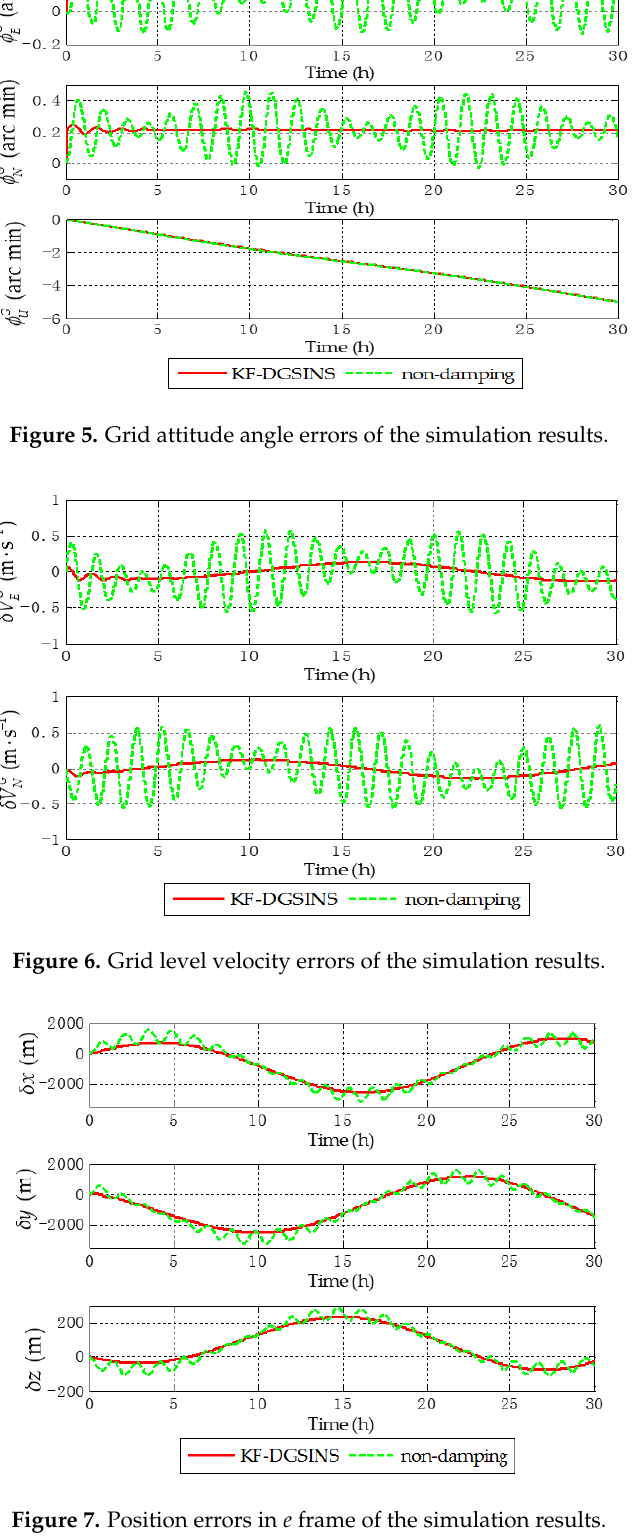
Figure 7. Position errors in e frame of the simulation results.